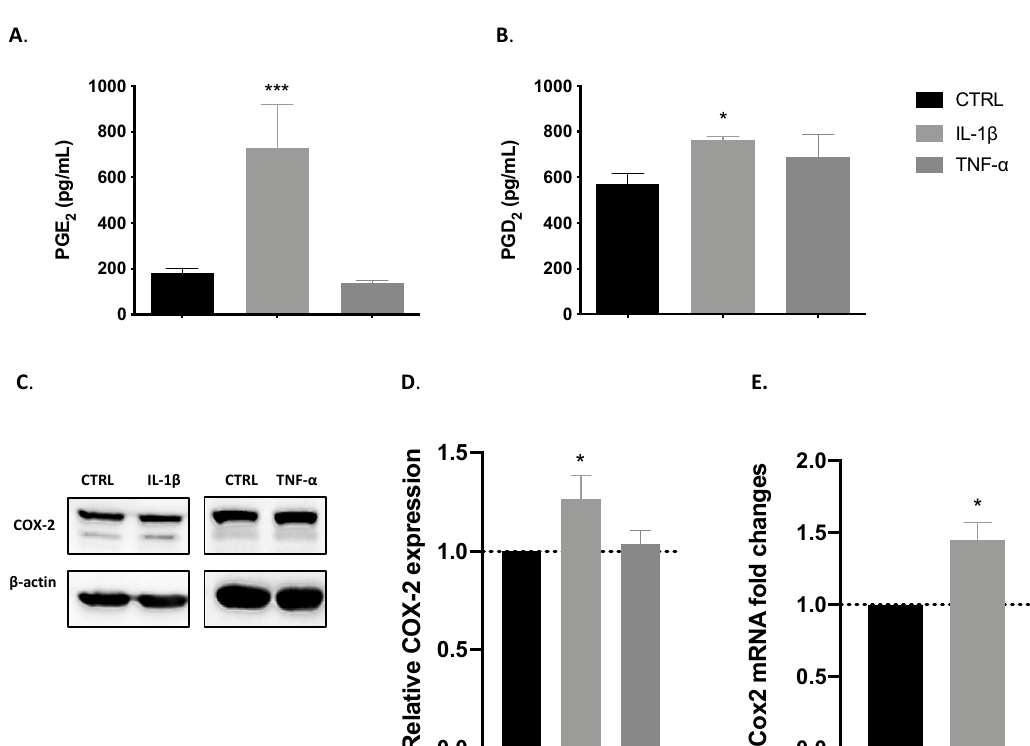
Figure 2. IL-1 β induces the release of prostaglandins and cyclooxygenase 2 (COX-2) expression. Bar charts represent effects of control (black), IL-1 β (gray), and TNF- α (dark gray) on the release of prostaglandins and on COX-2 expression. ( A ) IL-1 β positive effect on prostaglandin E 2 (PGE 2 ) and ( B ) PGD 2 release. ( C ) Representative blotting of COX-2 protein expression. ( D ) Relative COX-2 protein expression was increased by IL-1 β treatment. ( E ) mRNA levels of the Cox2 gene were also increased by IL-1 β . Data are shown as mean ± SEM (* p < 0.05 and *** p < 0.001 from unpaired t -test).